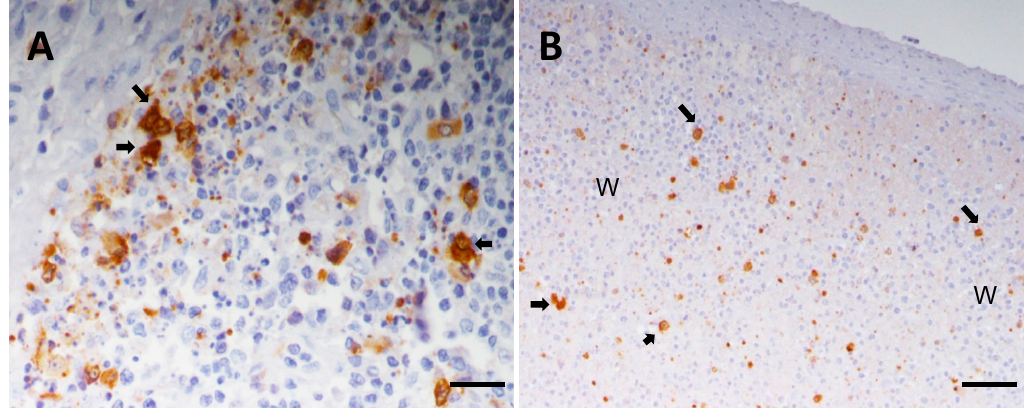
Figure 5. Immunohistochemical detection of ASFV protein P30 on wax-embedded tissue sections from pigs inoculated with the highly virulent ASFV isolate OURT88/1 and euthanized at day 5 post-infection. ( A ) Tonsil, Bar 40 µ m. Lymphoid follicle with severe lymphoid depletion. Observe the presence of infected macrophages (arrows) close to areas where lymphocytes show characteristic features of apoptosis such as reduced size and hyperchromatic nuclei. Cell debris and apoptotic